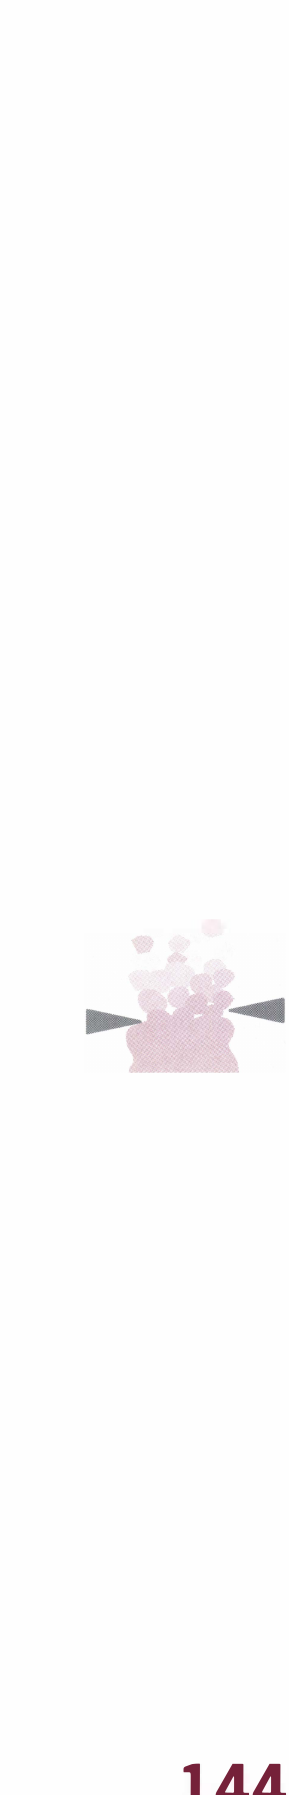
Fig. 8: Shear stress , first normal stress difference N 1 and Bagley pressure correction llPE of Lupolen 1800 S as a function ot